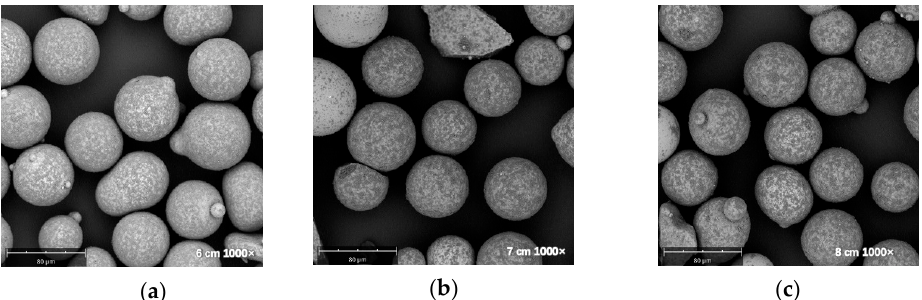
( a ) 0 wt%; ( b ) 0.5 wt%; ( c ) 1.0 wt%; ( d ) 1.5 wt%.